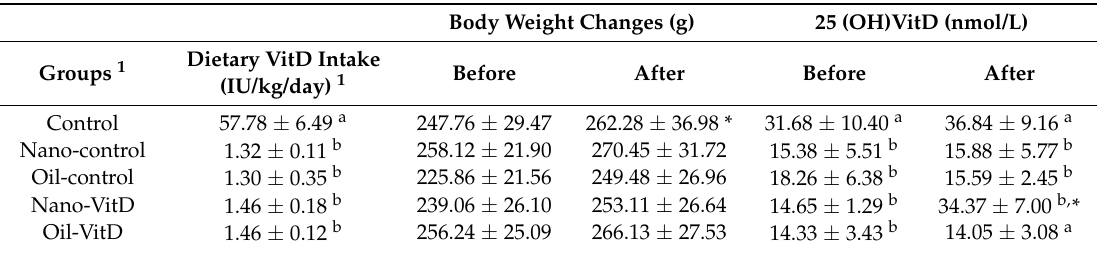
Table 1. Rat body weights and levels of 25(OH)VitD in serum before and after one week of treatment. Body Weight Changes (g) 25 (OH)VitD (nmol/L)